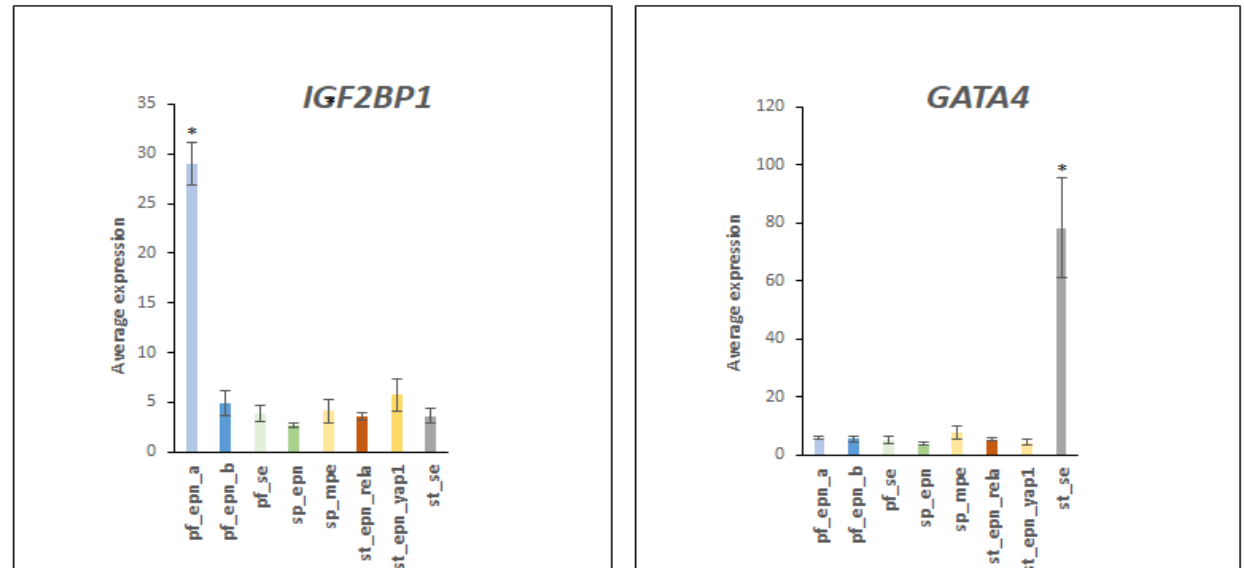
Figure 13. The IGF2BP1 gene expression is selectively elevated in the PF_EPN_A subtype (F = 30.48, p = 1.66 × 10 − 28 ) and GATA4 expression is elevated in the ST_SE subtype (F = 57.00, p = 2.16 × 10 − 44 ). * significantly different from other groups by t -test p < 0.001 for IGF2BP1 and p < 0.01 for GATA4. Dataset GSE64415.